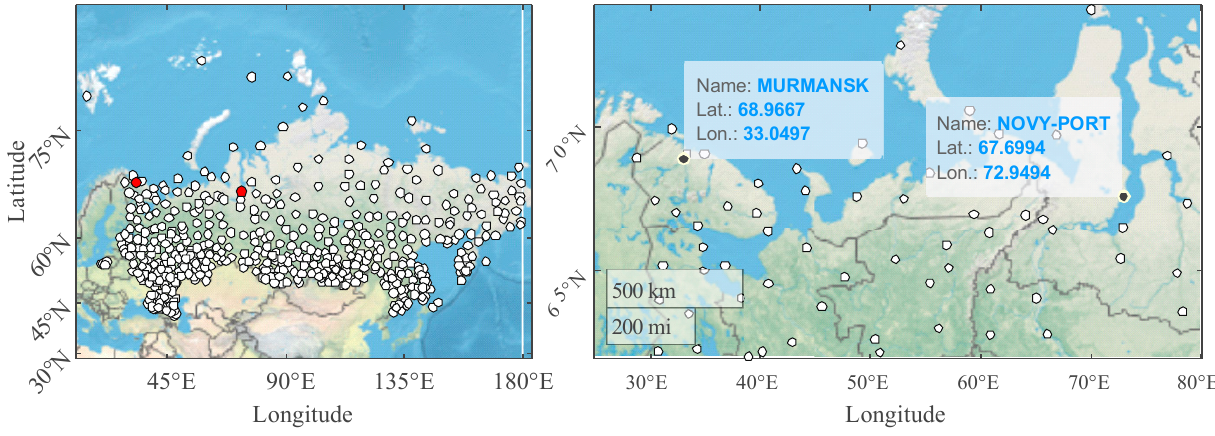
Figure 2. Map of weather stations locations.